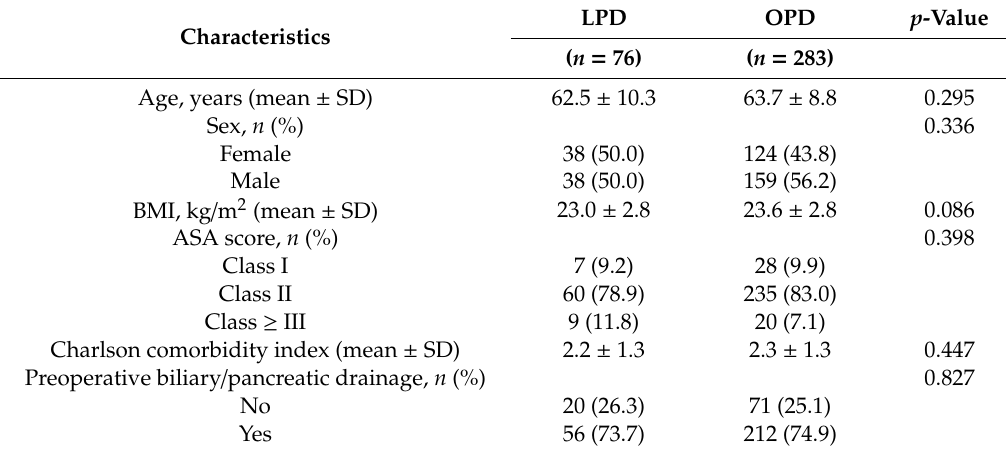
Table 1. Demographic characteristics and preoperative factors of all unmatched patients who underwent laparoscopic pancreaticoduodenectomy (LPD) or open pancreaticoduodenectomy (OPD).